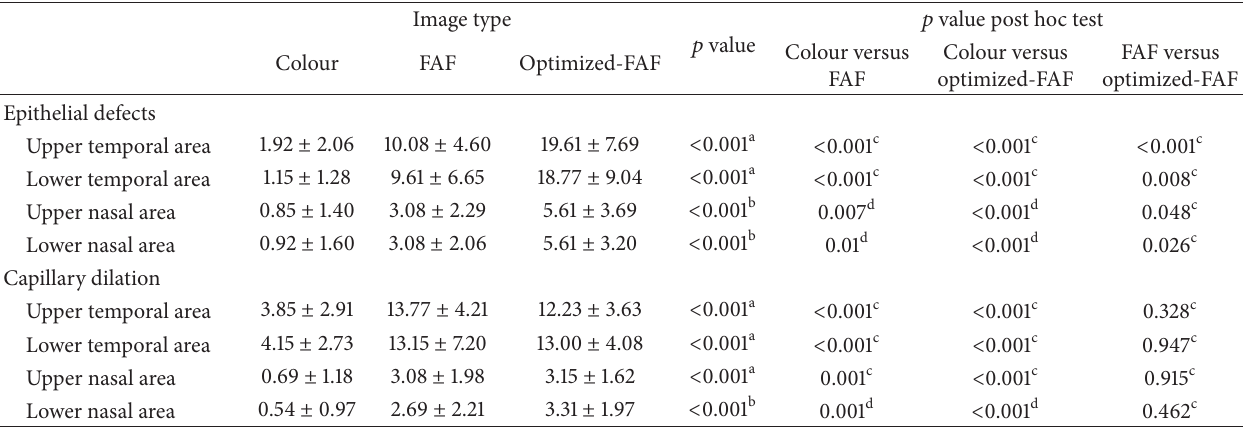
Table 4: Distribution of retinal alterations observed in colour, FAF, and optimized-FAF images in control